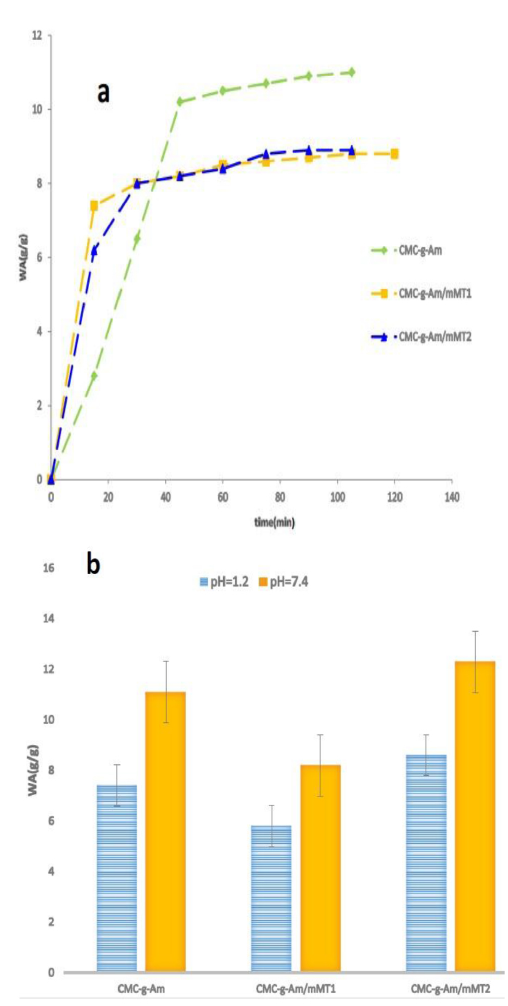
Fig. 3. (a) The hysteresis loops of CMC-g-Am/mMT1 and CMC-g-Am/mMT2 hydrogels versus applied magnetic field. (b) TEM image of CMC-g-Am/mMT2.